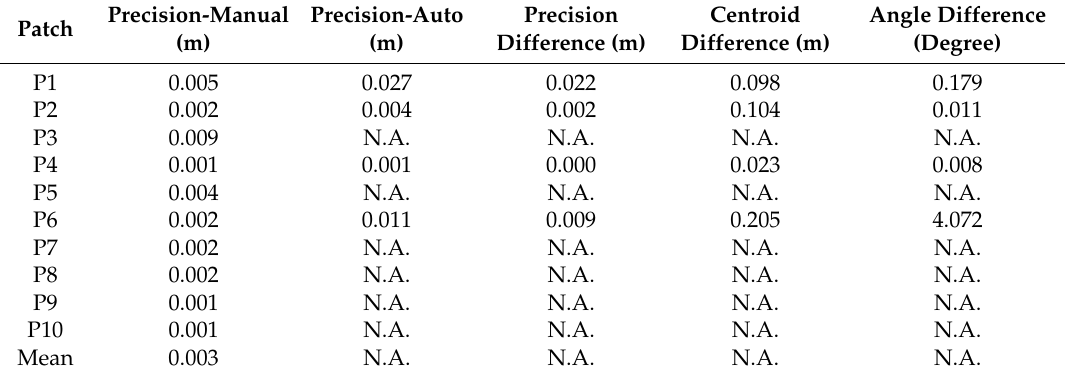
Table 13. Plane fitting precision, plane fitting precision difference, centroid difference, and angle difference values for building #4 (Spherical approach).